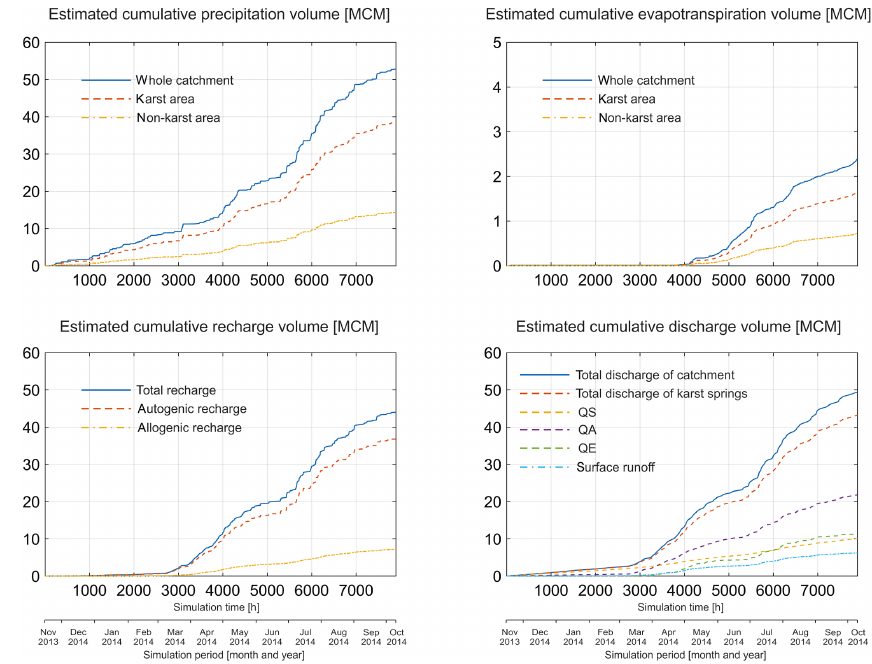
Figure 5. Estimated cumulative volumes of precipitation, evapotranspiration, recharge and discharge for the studied catchment for the period November 2013–October 2014 on an hourly time step in million cubic meters